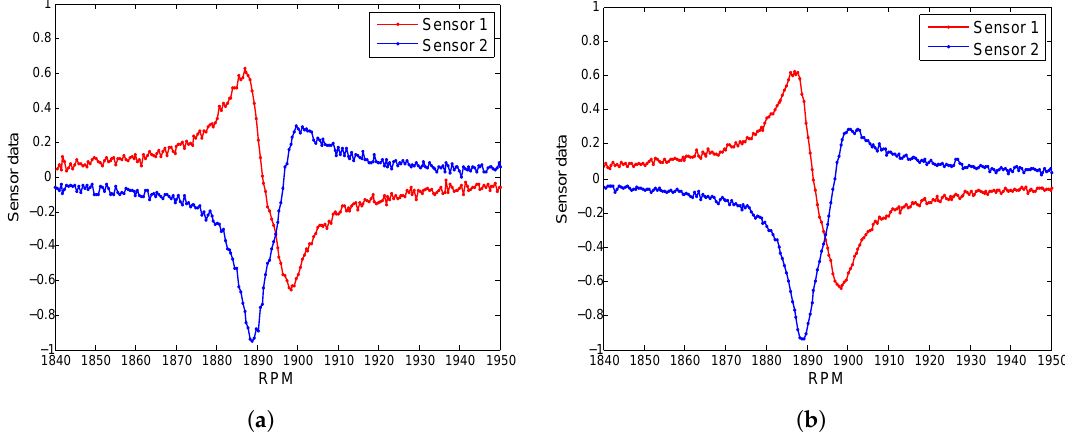
Figure 13. Typical sensor data contaminated by noise for EO = 5 and SD = 0.10, ( a ) Signal-to-Noise Ratio (SNR) = 20 dB, ( b ) SNR = 25